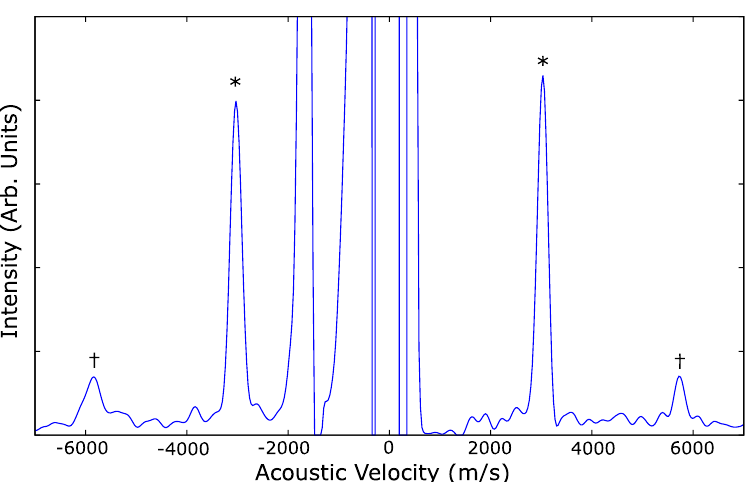
Figure 1. Brillouin spectrum of cerium dioxide nanopowder at 3.6 GPa. Transverse modes are marked with asterisks, longitudinal modes occur at higher shift and are marked with daggers.